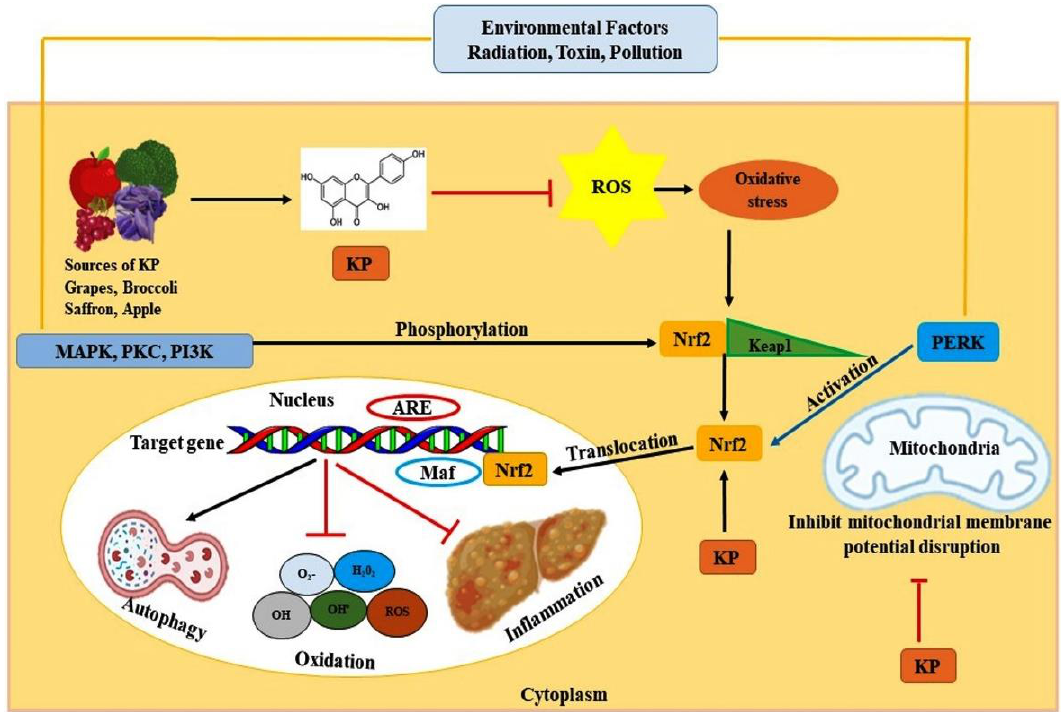
Figure 2. Antioxidant mechanism of KP via Nrf2-Keap1 pathway. KP inhibits the metabolism of ROS by acting on the Nrf2-Keap1 complex. The level of Nrf2 is augmented by KP after its disassociation from the complex. Nrf2 translocates to the nucleus and binds with ARE along with Maf transcription factor, which triggers the expression of the genes, inducing autophagy, inhibiting oxidation and inflammation. KP also plays a vital role in suppressing the mitochondrial membrane potential disruption and thus leading to restoration of normal physiological condition. Abbreviations: KP, kaempferol; Nrf2, nuclear factor erythroid 2 related factors 2; Keap1, Kelch-like ECH-associated protein 1.